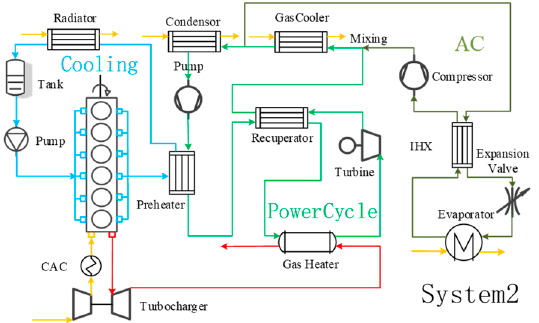
Figure 9. Co-cooling secondary cooling